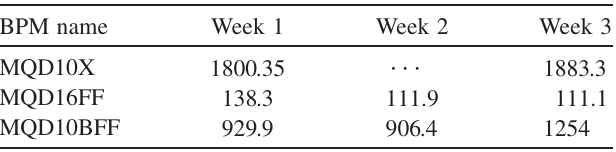
TABLE IV. Vertical calibration scale S period.